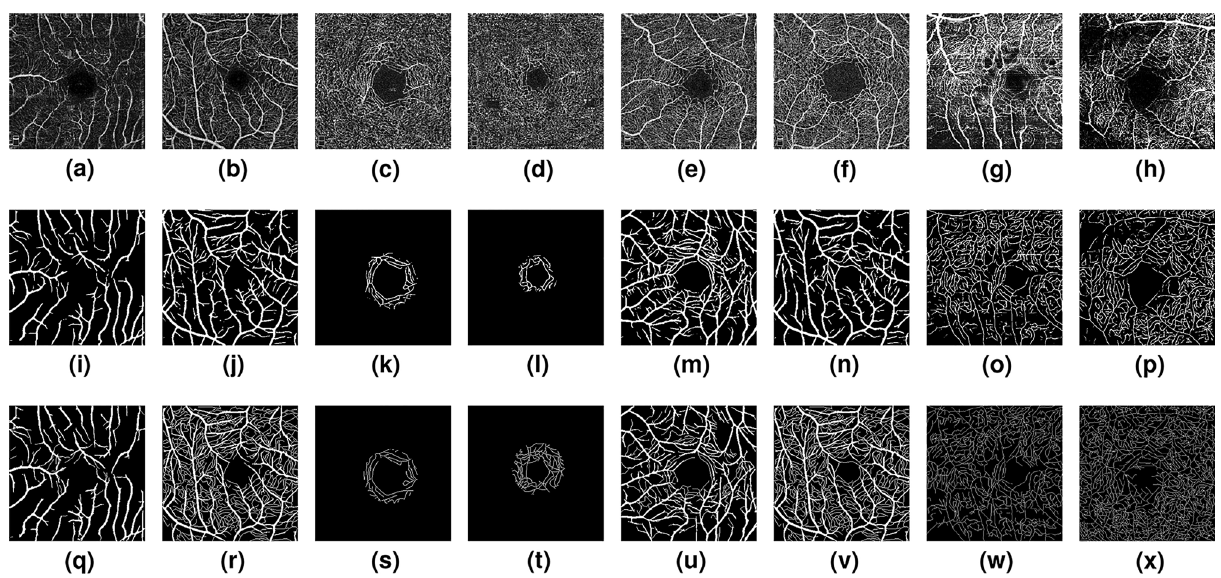
Figure 6. OCTA vessel segmentation. ( a , b ): SVC images, ( c , d ): DVC images, ( e , f ): SVC+DVC images, ( h , i ): Rose-2 images. The second row shows predicted probabilities and the third rows corresponding manual ground- truths. Each pair shows representative best and worst case segmentations in the corresponding test